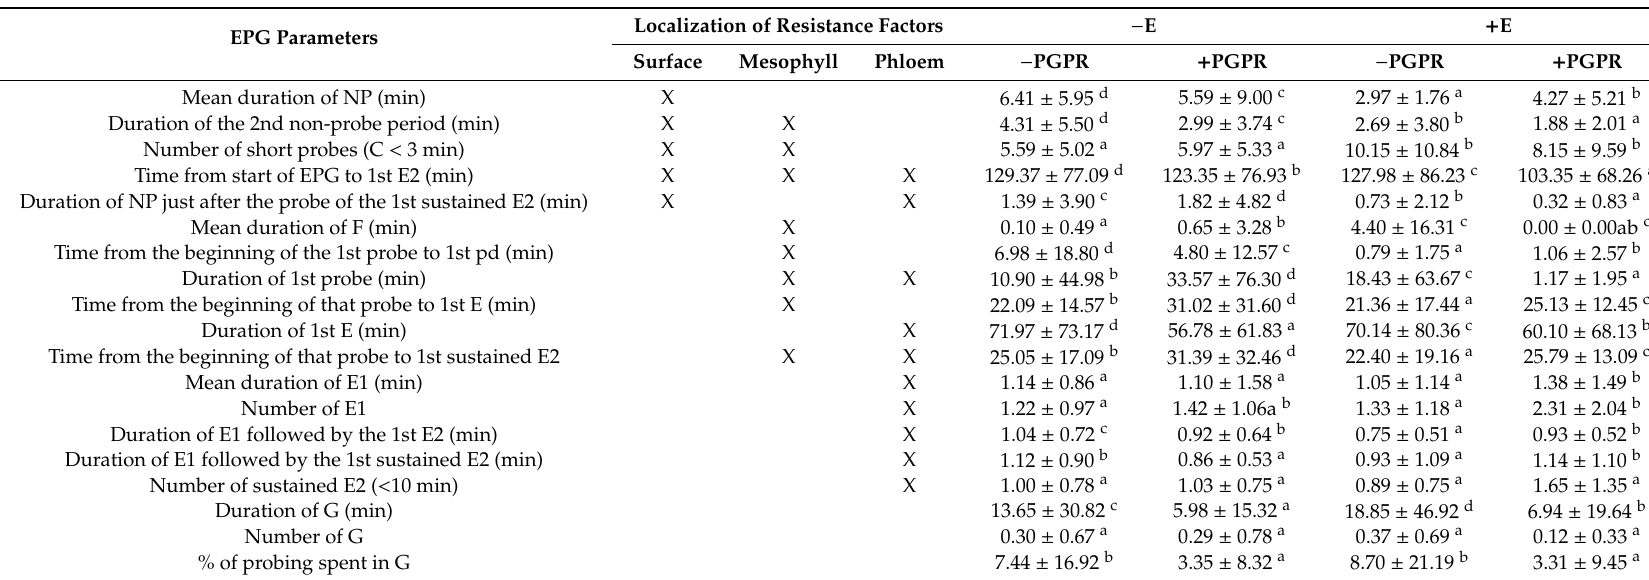
Table 2. The mean ± SD of significantly discriminant electrical penetration graph (EPG) parameters, for − E and + E clones of A. pisum on B. amyloliquefaciens -treated or control plants. NP: non-probing; C: stylet pathway phase; pd: potential drop related to cell punctures; G: xylem ingestion; F: di ffi culties during stylet penetration; E1: salivation into sieve elements; E2: phloem ingestion; E: phloem phase including E1 and E2. The di ff erent letters within rows indicate statistically di ff erences ( p <